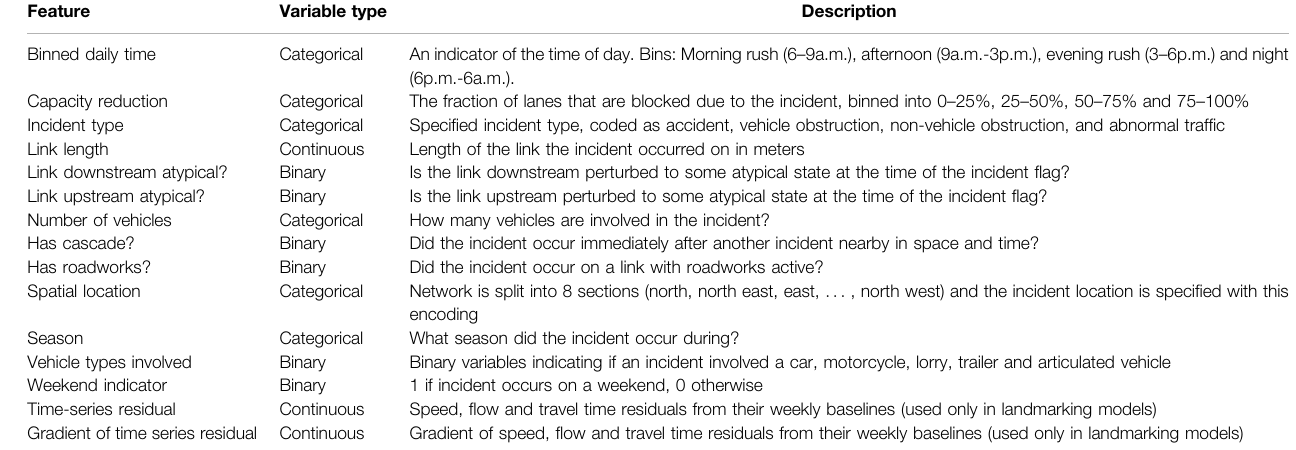
TABLE1| Overviewofthefeaturesconsideredforincidentdurationmodeling.ThesewouldberecordedbyanNTISoperatorwhenanincidentisdeclaredinthesystemand observed on the network. The time-series features are recorded by inductive loop sensors along the road, and reported each minute. We further consider machine learning models that engineer time-series features